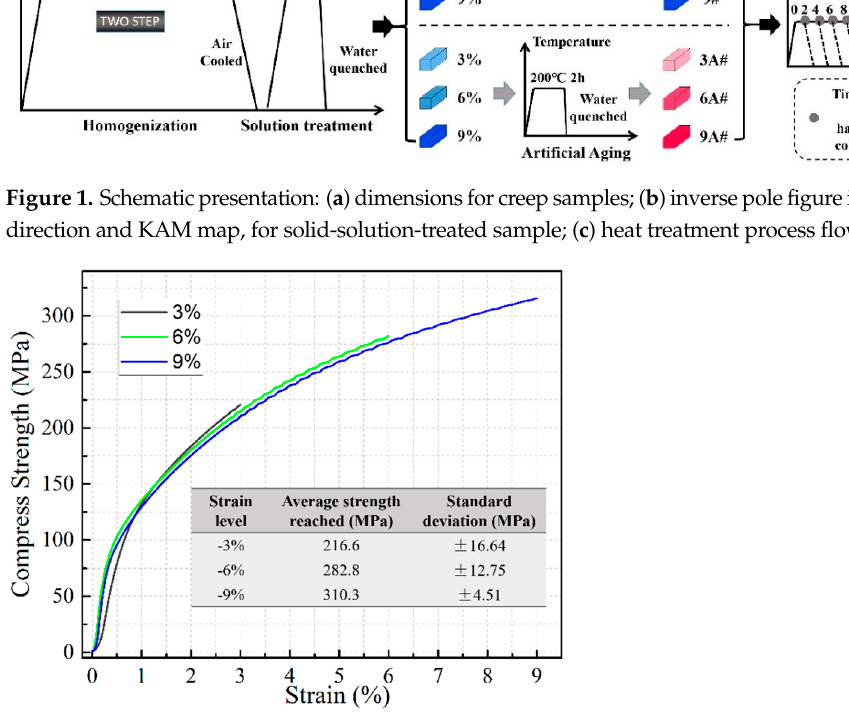
Figure 2. Pre-compressive deformation at different strain levels and corresponding strength reached. Table 2. Experimental parameters of creep